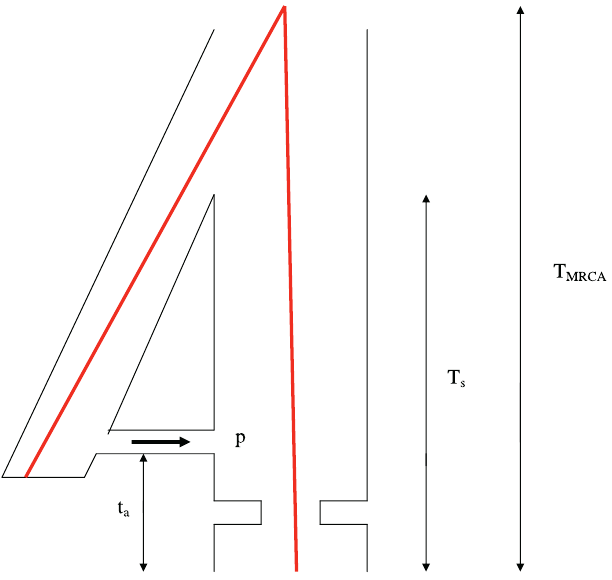
Figure 4. Schematic of the Population Model Used The Neanderthals contribute a proportion p to the ancestry of CEU individuals t a generations in the past, where t a ¼ 1,800 (see Noonan et al. [1]). T s is the split time of the two populations. The red lines show the ancestry of a particular Neanderthal and modern human sequence. They coalesce at time T MRCA in the past.